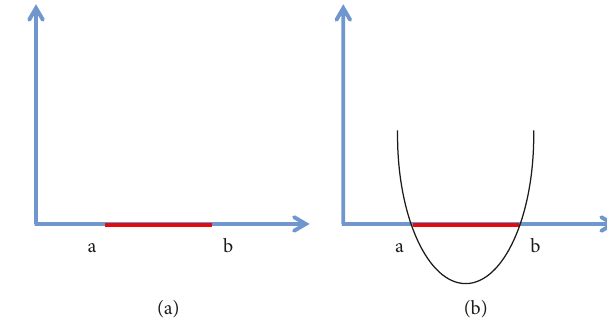
Figure 4: Classic example of SVM principle.